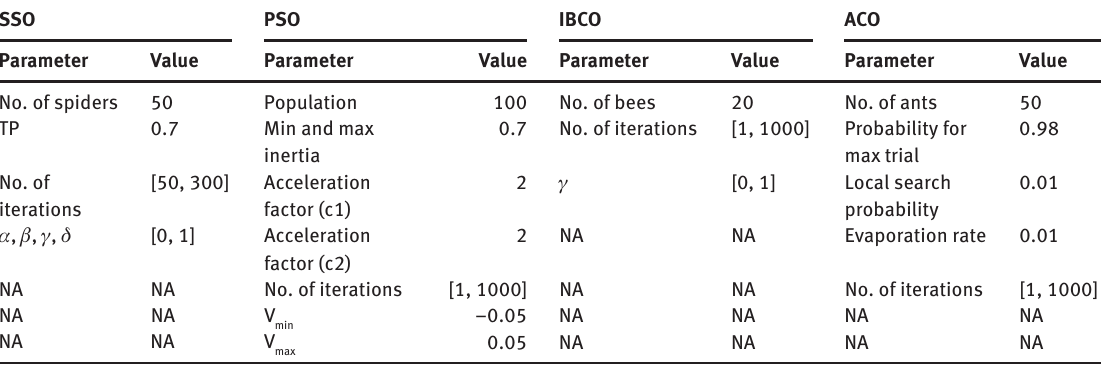
Table 10: Values of Parameters for Different Clustering Algorithms.